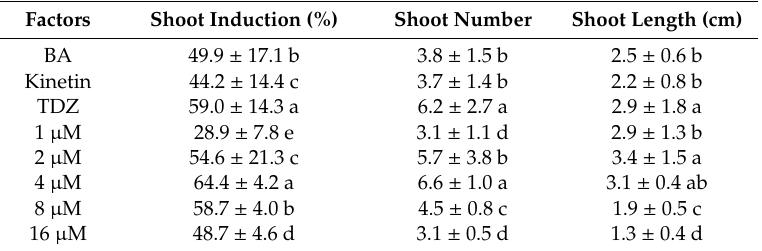
Table 2. E ff ect of cytokinins and their concentration on multiple shoot regeneration from nodal explants of Catharanthus roseus .